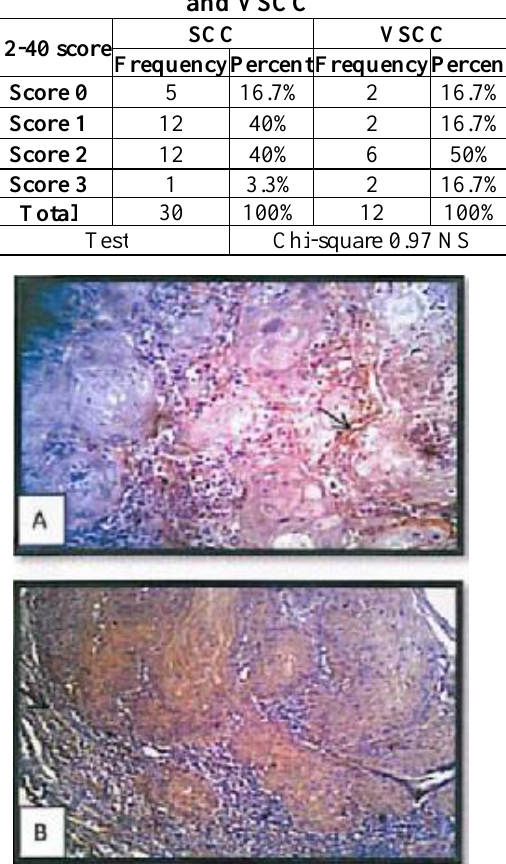
Figure 3: D2-40 immunoexpression in